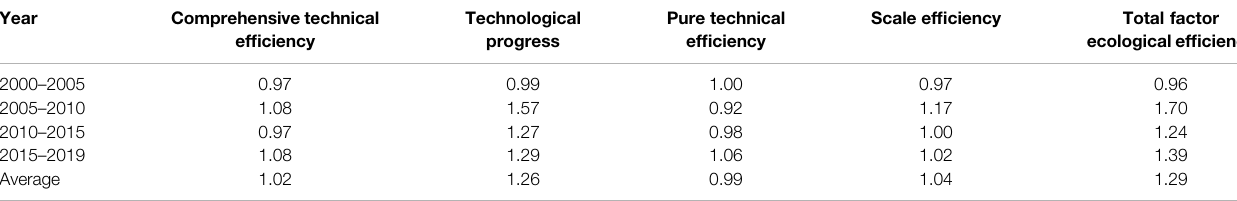
TABLE 4 | Average Malmquist index and its decomposition in Tongliao.